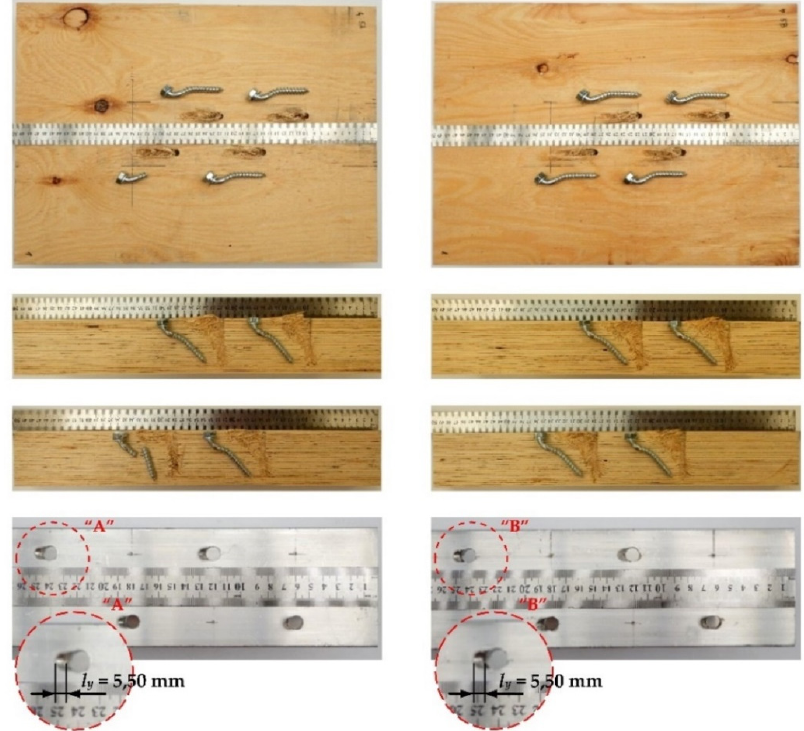
Figure 10. The mode of failure of the aluminium-timber connection with the 10 mm screws and without the reinforcing toothed plates.